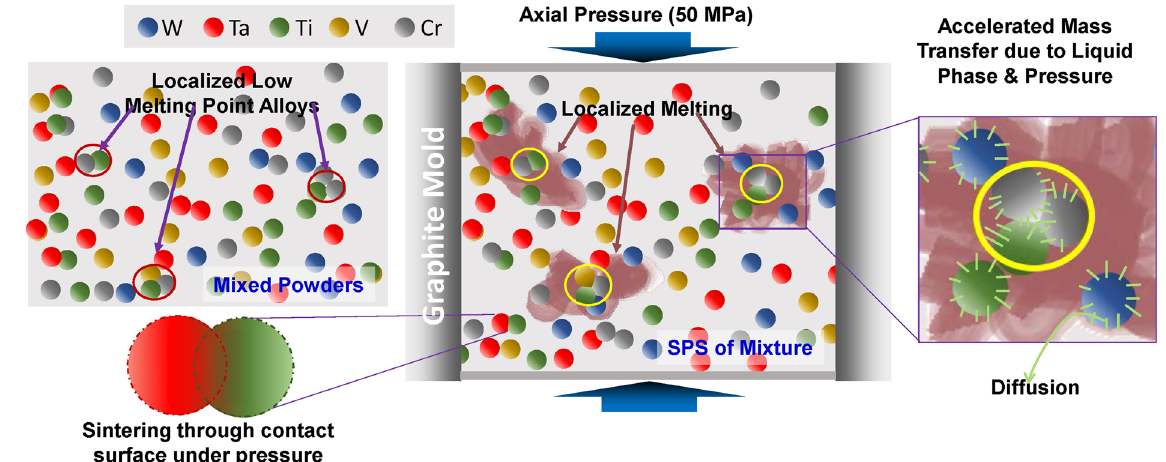
Figure 2. Illustration of sintering mechanism of W x TaTiVCr alloy